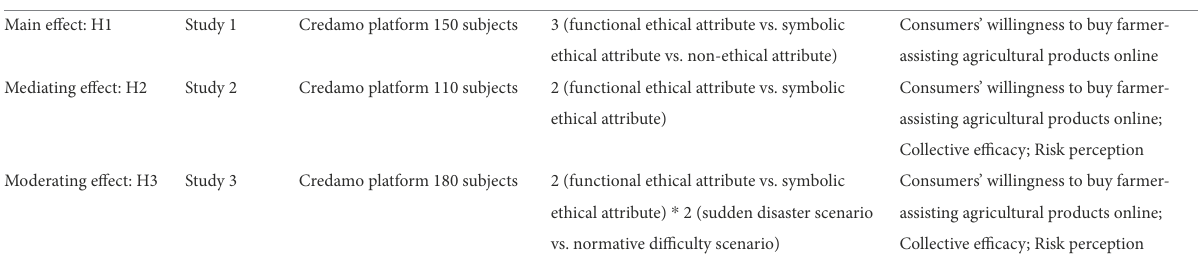
TABLE 2 Outline of the